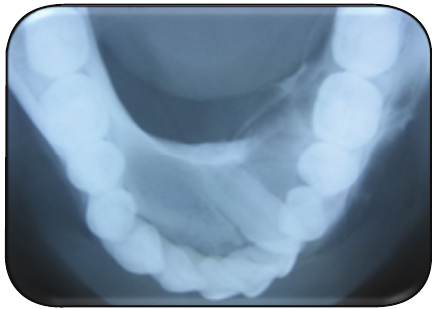
Figure 3: Occlusal radiograph.